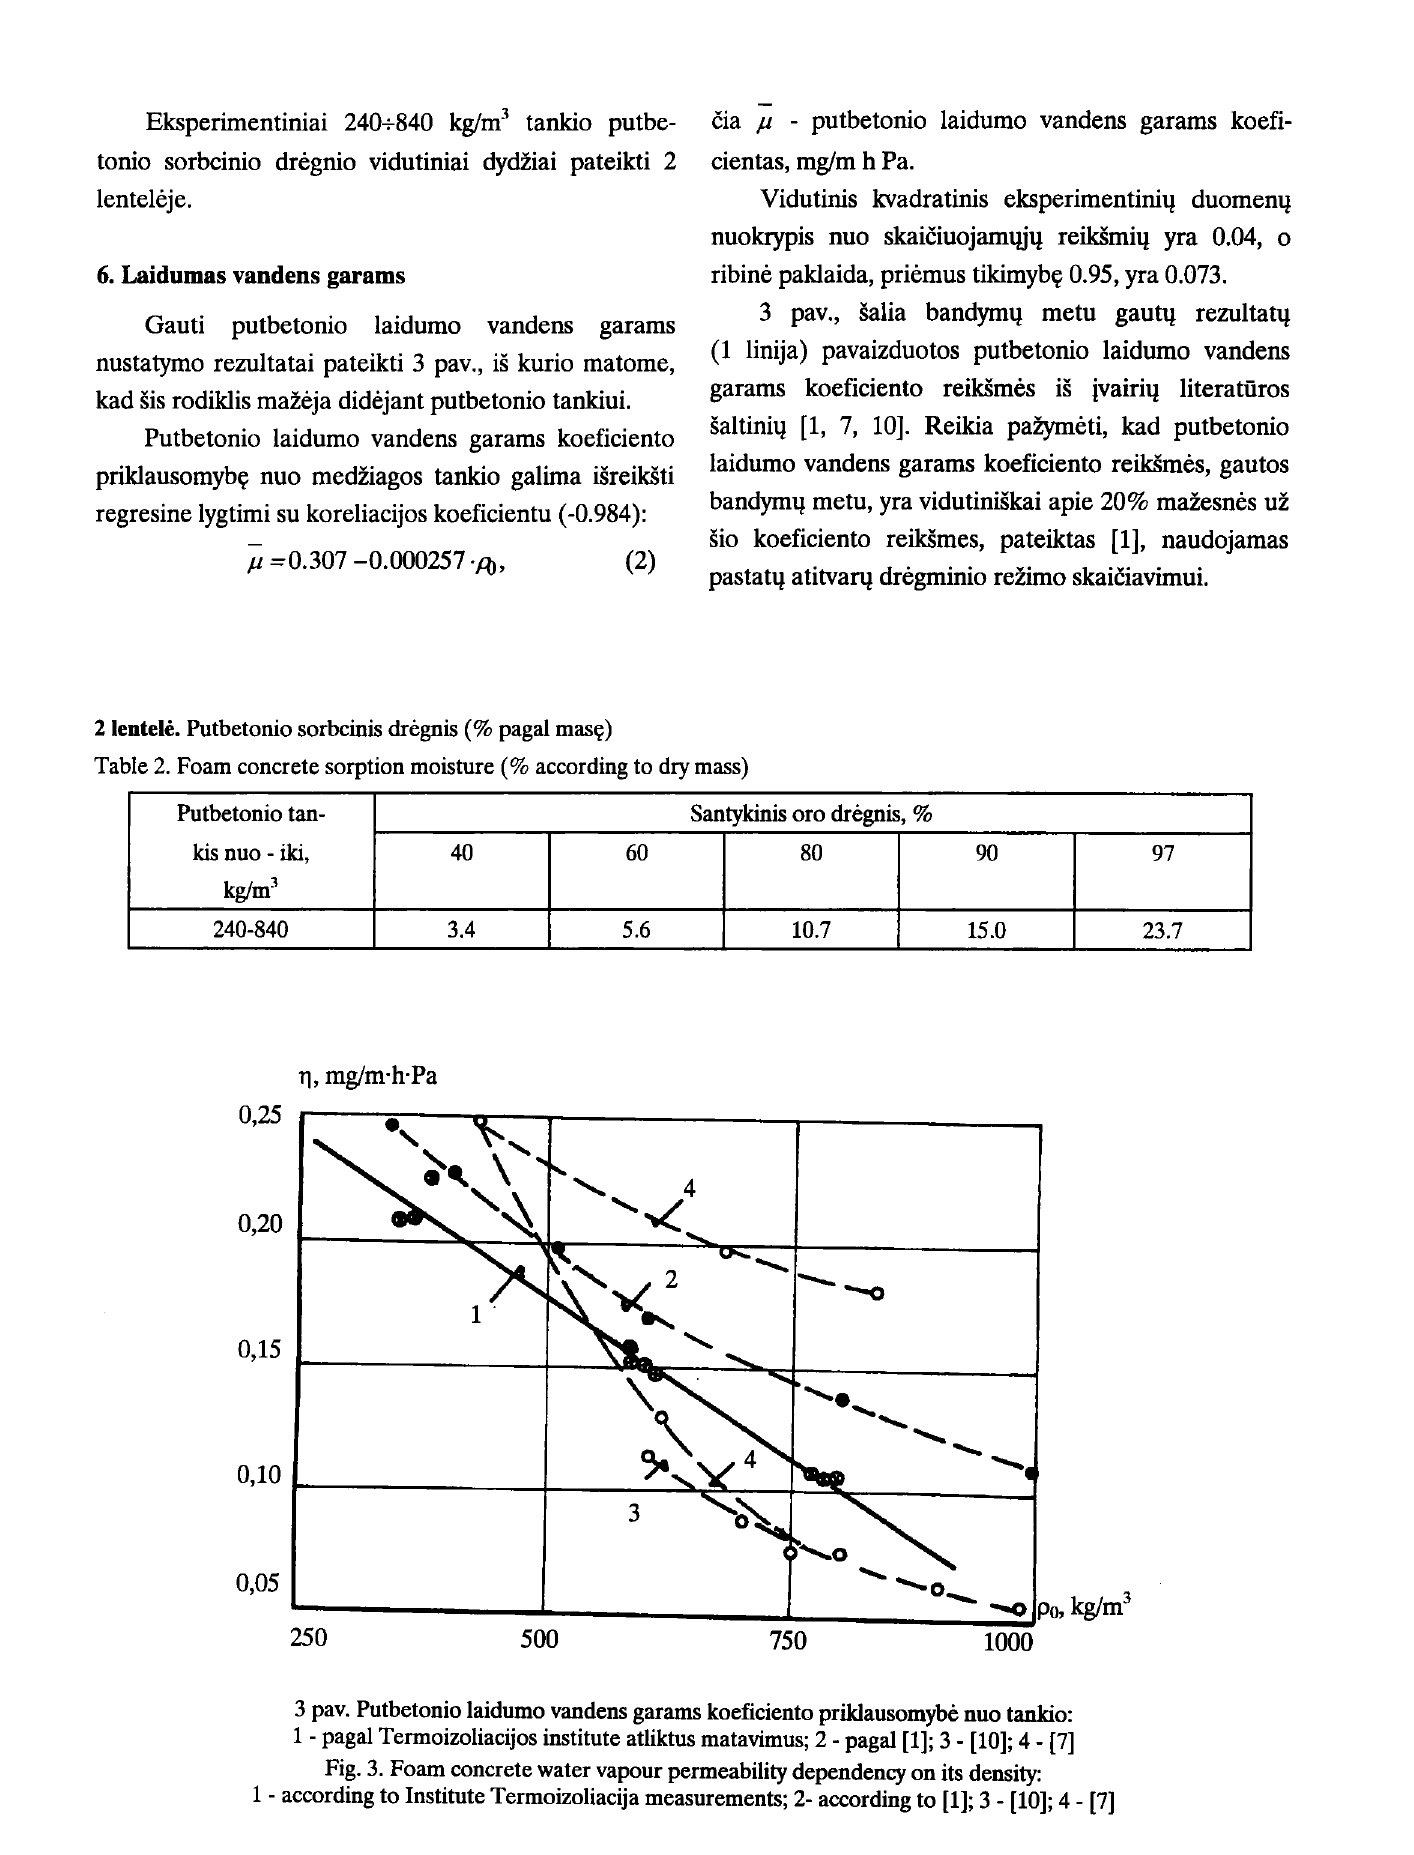
Fig. 3. Foam concrete water vapour permeability dependency on its